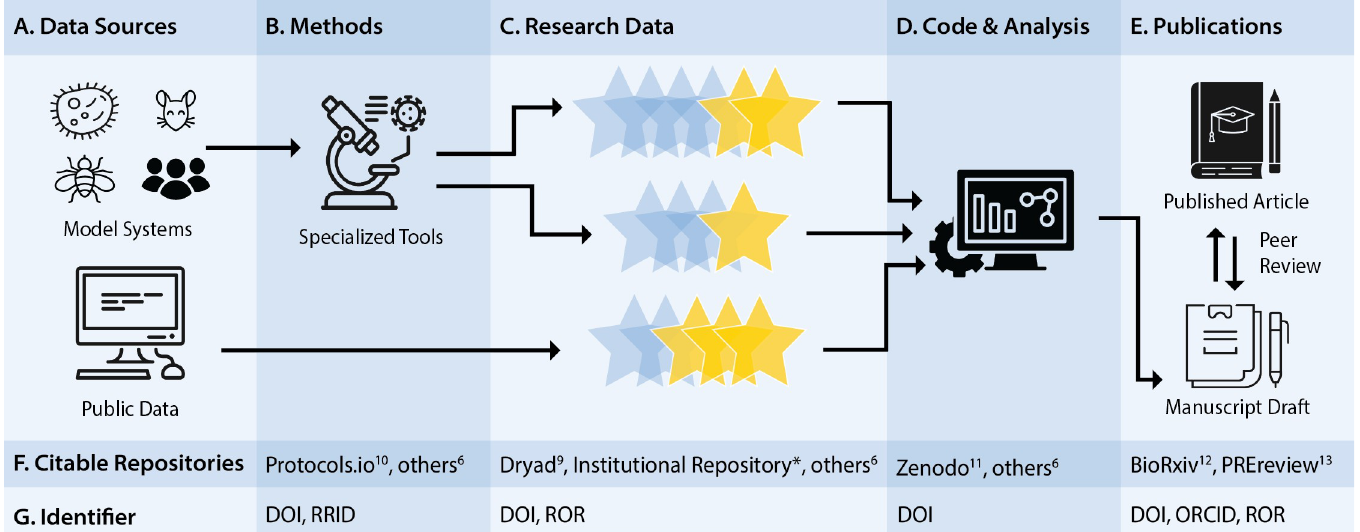
Fig 1. A typical research workflow. (A–E) Major steps of the research workflow. (F) An example set of citable repositories or tools used to find research products outside of journal articles. (G) Persistent identifiers used for the example repositories listed. DOI, digital object identifier; ROR, Research Organization Registry; RRID, research resource identifier; ORCID, open researcher and contributor